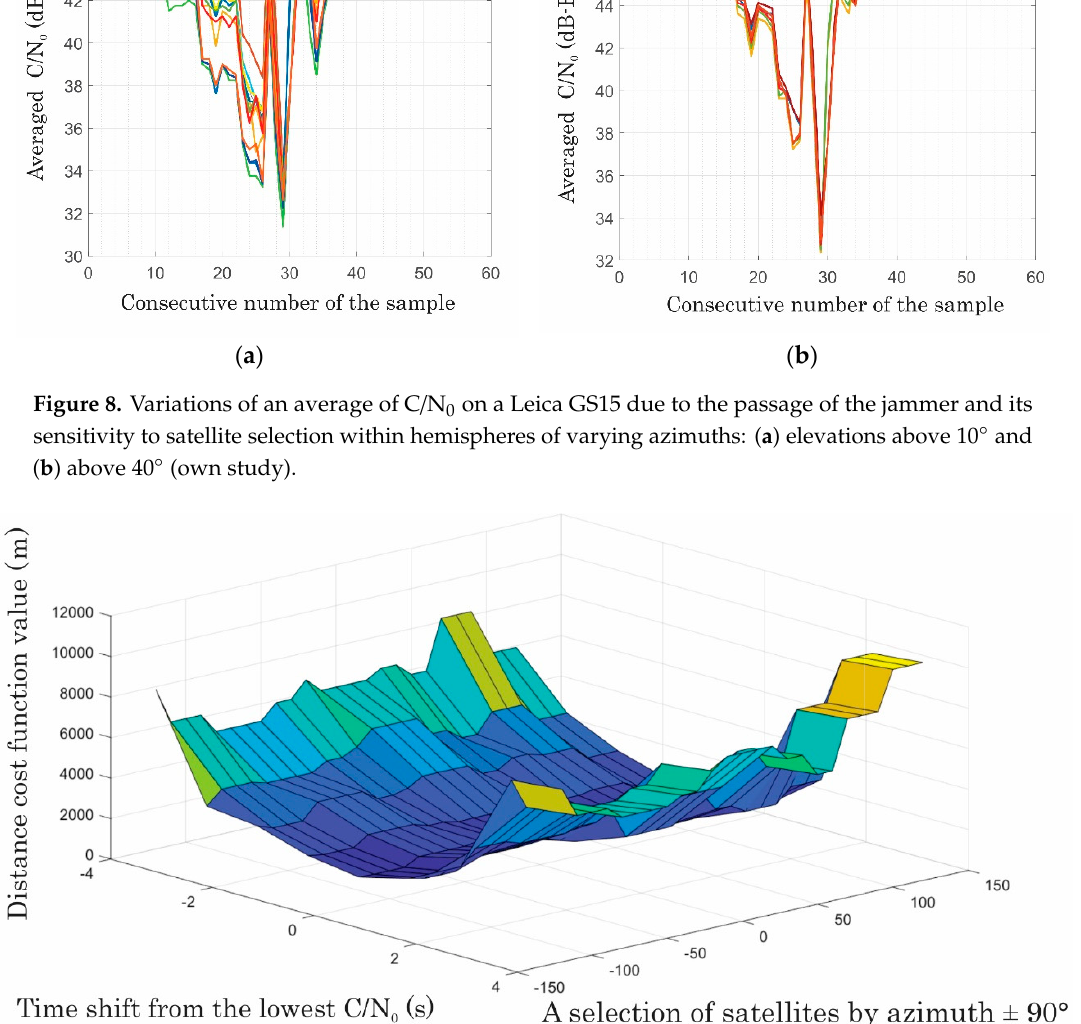
Figure 9. Sensitivity of the distance related cost function on satellite selection by azimuth at a minimum elevation of 35°, and the time shift of C/N 0 vs. the closest distance jammer-receiver for Leica GS15 during the last test at 90 km/h (own study).